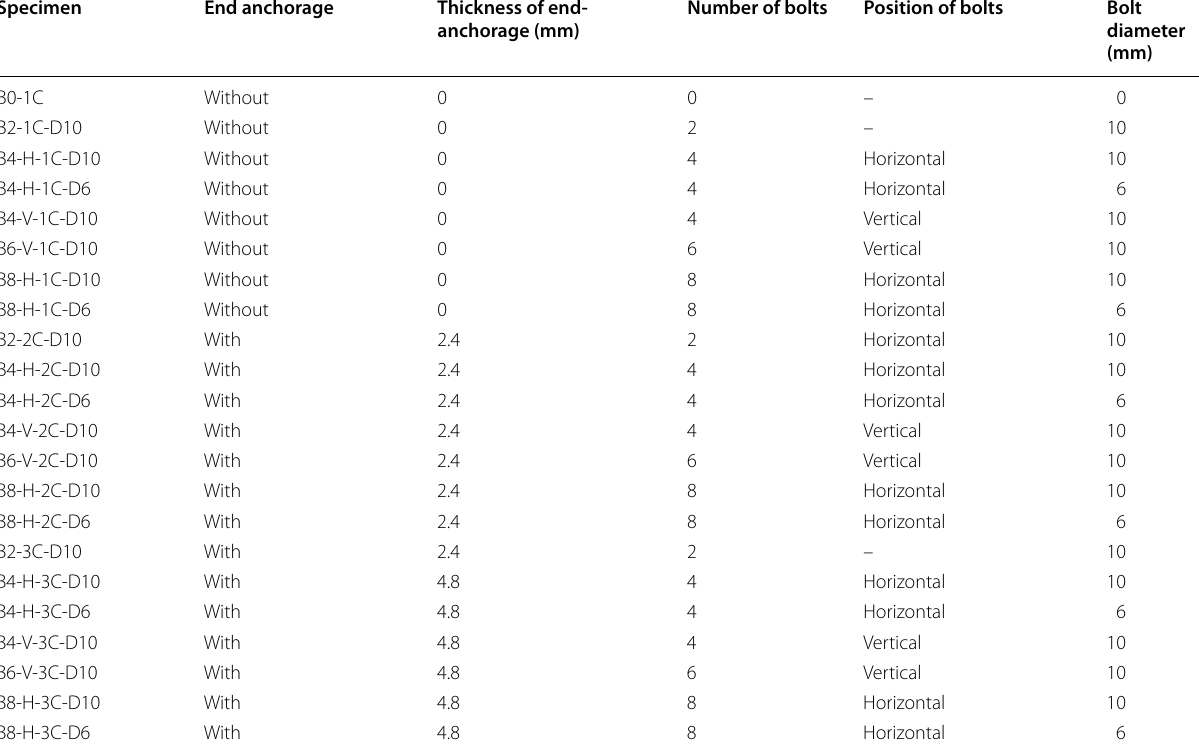
Table 3 Technical details of the end-anchorages and the bolts Specimen